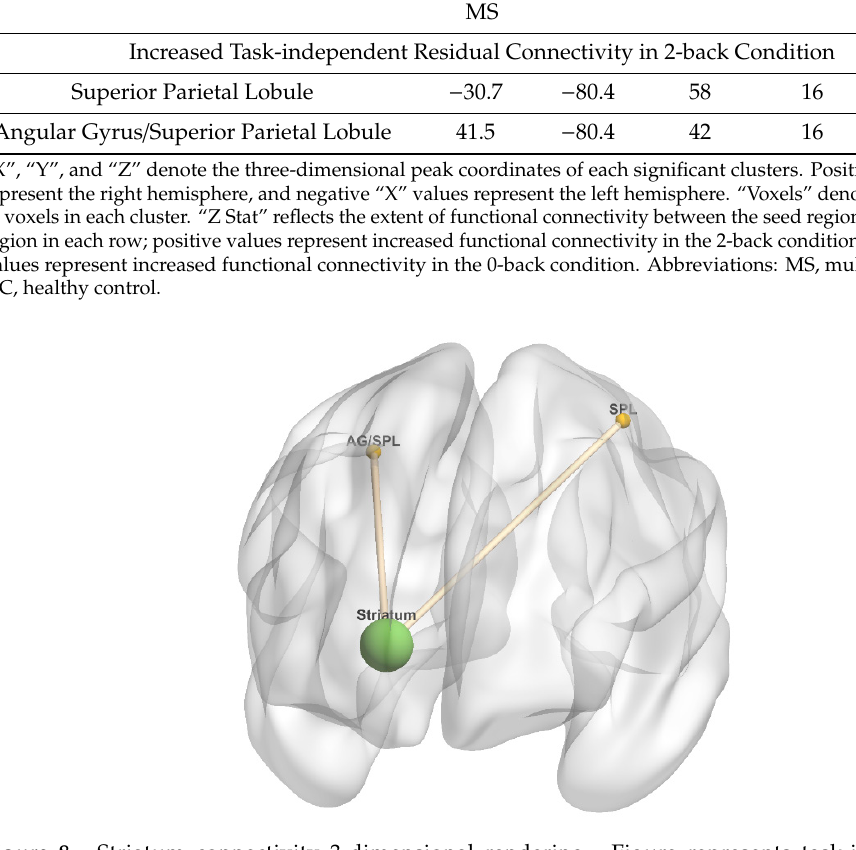
Figure 8. Striatum connectivity 3-dimensional rendering. Figure represents task-independent, fatigue-related connectivity in the multiple sclerosis group; there were no significant differences between conditions in the healthy control group. The seed is denoted by a green sphere, and regions with increased connectivity to the seed in the 2-back condition are denoted by yellow spheres; there were no regions with increased connectivity to the seed in the 0-back condition. Anterior orientation is in the front of the figure; right hemisphere is on the left side, and left hemisphere is on the right side. Abbreviations: SPL, superior parietal lobule. AG, angular gyrus.